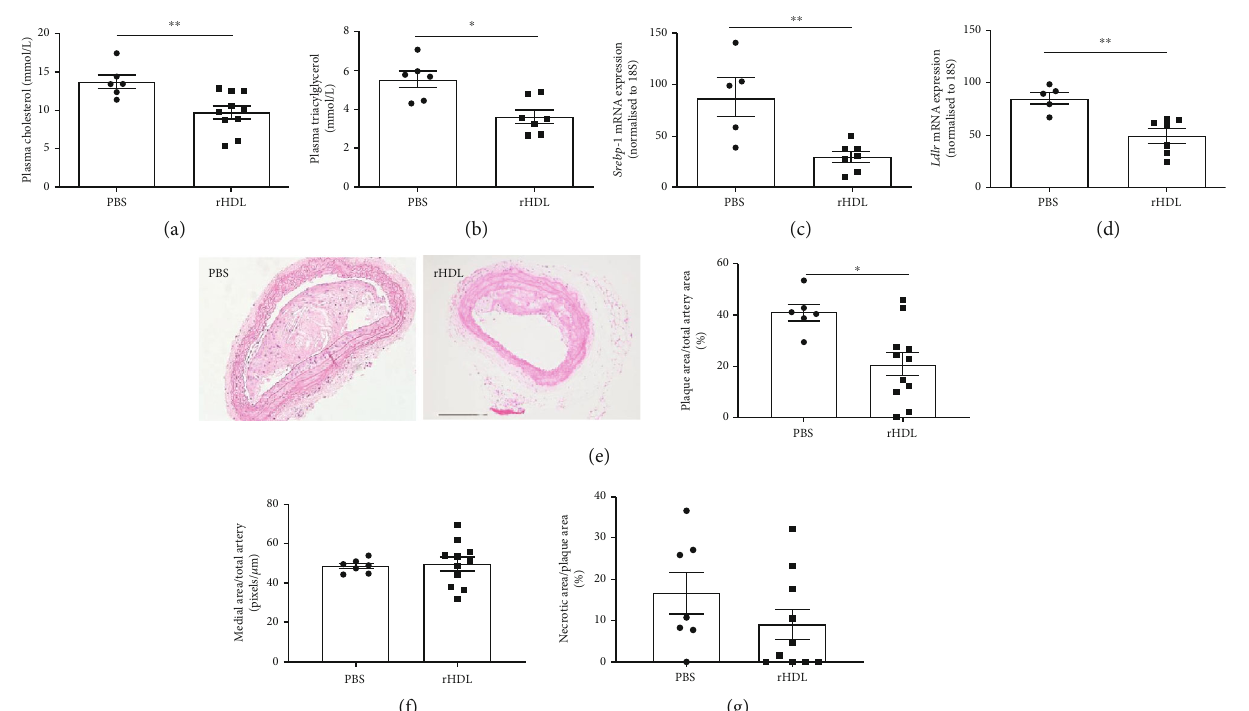
Figure 2: HDL reduces plasma cholesterol levels and atherosclerotic plaque in Western diet-fed Trail -/- Apoe -/- mice. Trail -/- Apoe -/- and Apoe -/- mice were fed a high-fat Western diet for 12 weeks. In the last 2 weeks of the study, mice received 3 weekly infusions of either rHDL (20 mg/kg) or PBS. (a) Fasting plasma cholesterol ( n = 6 -10) and (b) triacylglycerol levels ( n = 6 ) at euthanasia. rHDL reduced hepatic mRNA expression for (c) Srebp1 and (d) Ldlr in 12 w Trail -/- Apoe -/- mice. mRNA was extracted from liver as described in Methods. mRNA expression was normalised to 18S; n = 5 -7. (e) Right panel: representative cross-section of brachiocephalic arteries stained with haematoxylin and eosin (10x magni fi cation). Left panel: quanti fi cation of plaque area. No change in (f) medial or (g) necrotic areas was observed ( n = 7 -11). Results are expressed as mean ± SEM ; ∗ p < 0 : 05 and ∗∗ p < 0 : 01 , Mann – Whitney t - test used in all conditions. rHDL: reconstituted high-density